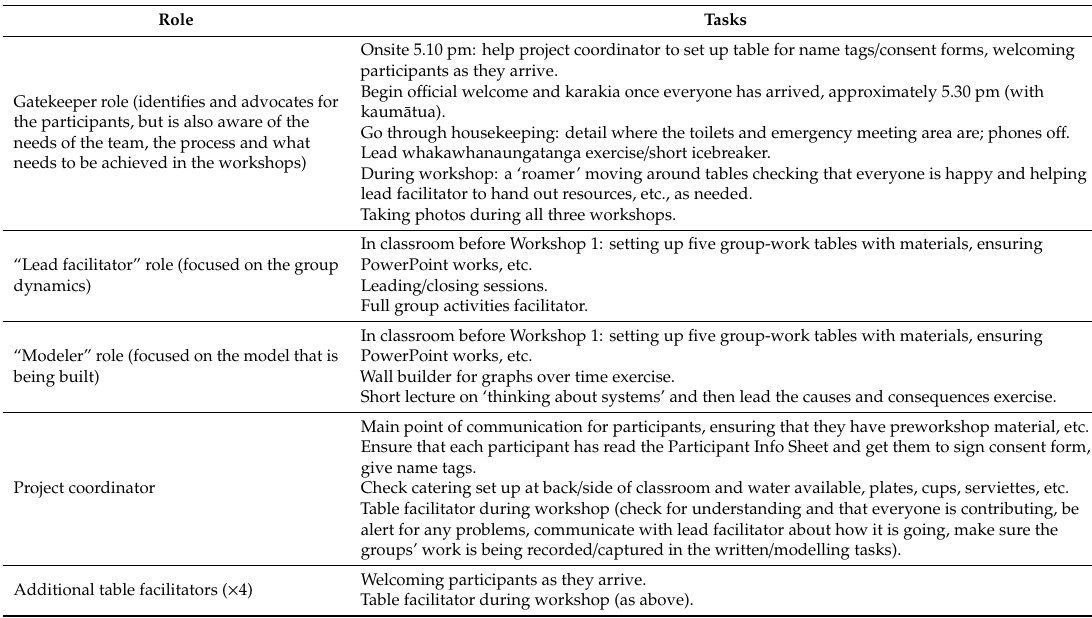
Table 1. Research team roles and tasks during the